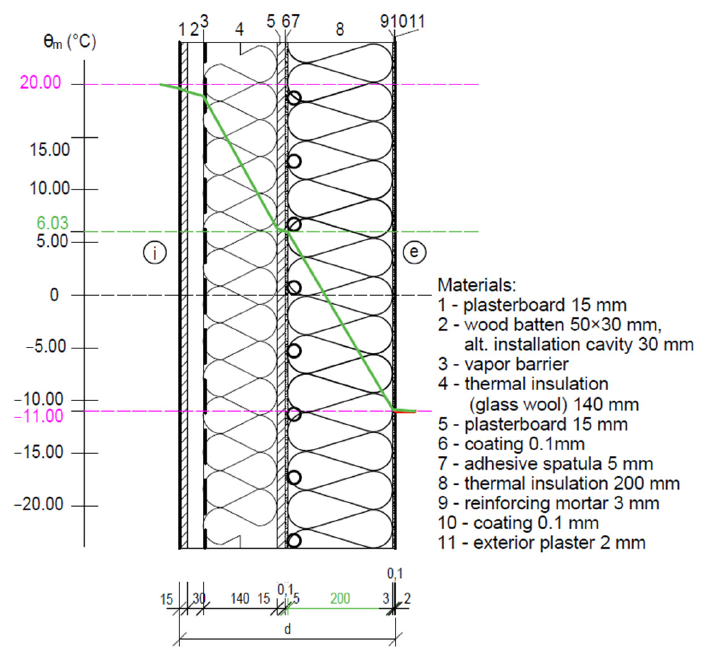
Figure 31. Mathematical-physical model of a test cell wall with a static insulation thickness of 200 mm. θ m —the temperature in construction (°C), d—construction thickness (mm), e—exterior, and i—interior.